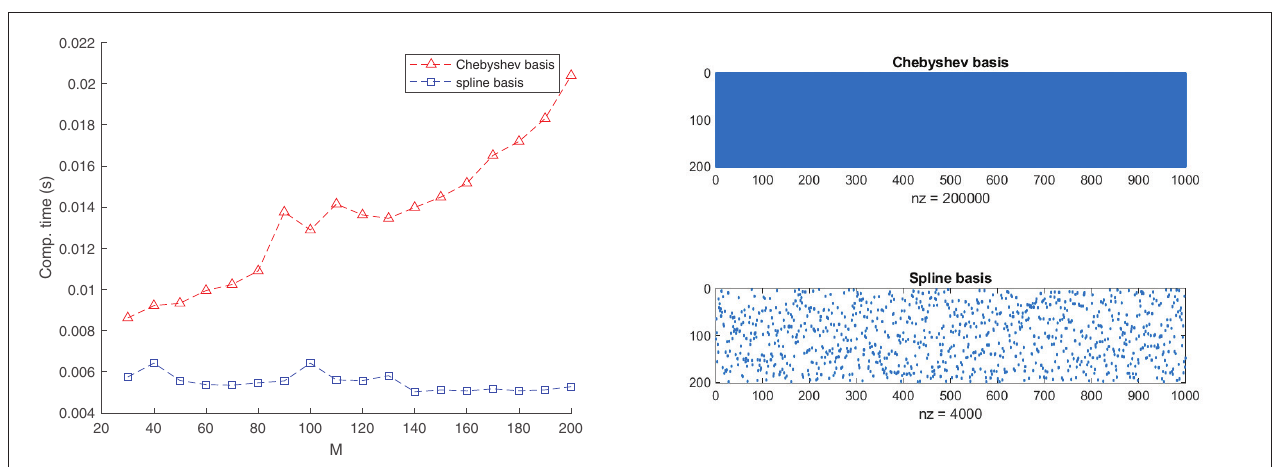
FIGURE 4 | Runge’s effects, as illustrated graphically in Figure 3 , resurface again when the function (Equation 19) is approximated with a sum of separable terms (Equation 8) where the B-spline basis is replaced with a Chebyshev basis. This occurs due to the non-analytic term makes (Equation 19) non-differentiable on the lines x 1 generated through minimizing the least-squares objective function (Equation 9), a Chebyshev basis will, unlike for B-splines, start exhibiting degrading performance when the number of basis terms becomes large with respect to the size of the dataset. This can be observed in the plot above, which shows the median RMSE obtained over 50 experiment, in each of which a different random set of function samples (derived from a uniform distribution) were used. For the experiments, the B-spline basis comprised of a uniformly distributed knot set. The oscillations in RMSE curve for the B-spline basis can be attributed to the fact that the knots will not always lie exactly on the non-differentiable region of the function.